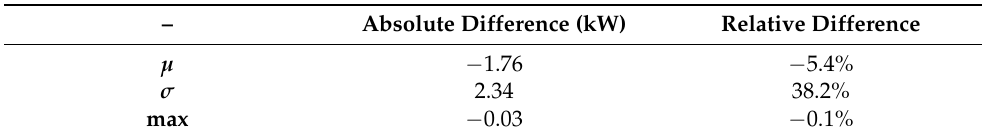
Table 14. Variation of the daily peak of the grid active power feed during May 2020 between Scenario C and Scenario B. µ : average value, σ : standard deviation, max: maximum value.